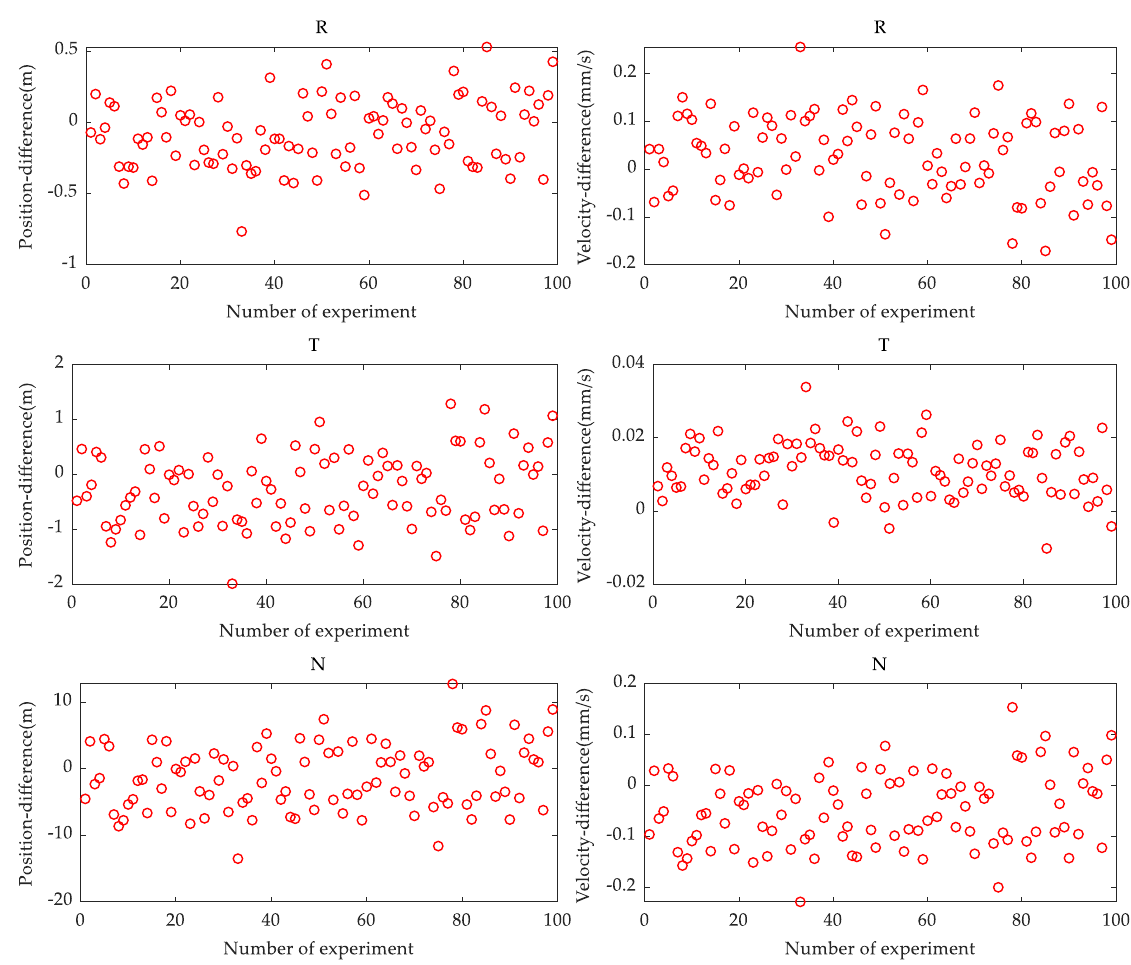
Figure 4. The orbital difference between initial spacecraft states computed with combined data (Doppler and image data) and a “true” initial spacecraft state. “R”, “T”, and “N” denote radial, tangential, and normal directions, respectively. (Left: position difference, Right: velocity difference).